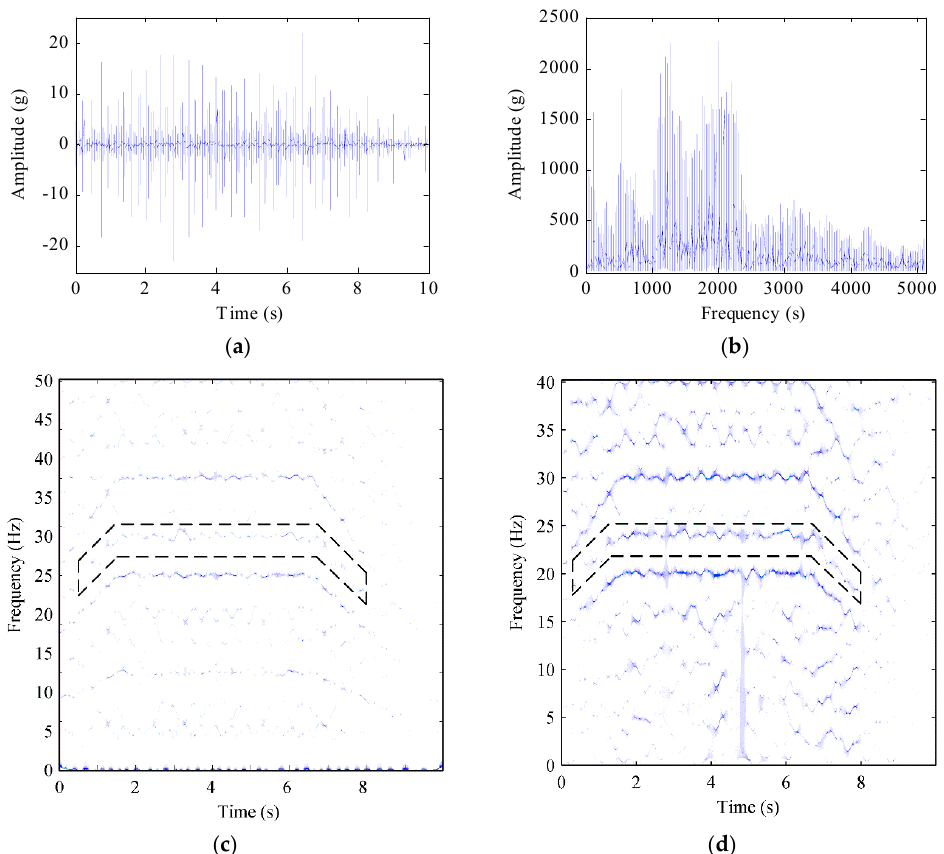
Figure 9. ( a ) Original vibration signal of the gearbox in time domain; ( b ) the spectrum of the vibration signal in frequency domain; ( c ) TFR of the signal using the SST method; ( d ) TFR of the signal using the proposed method.